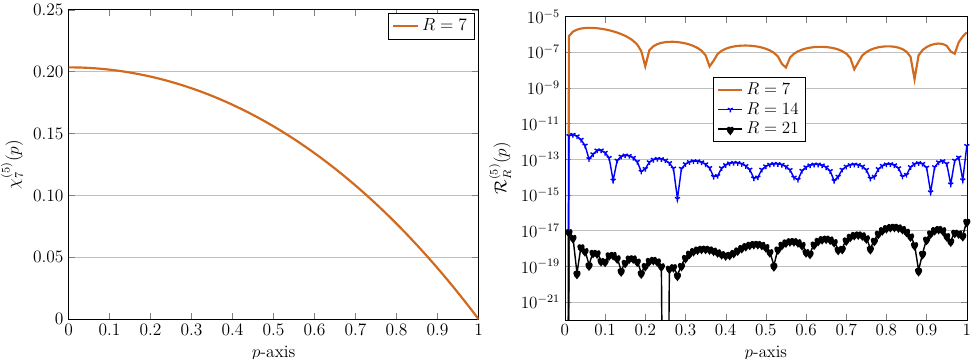
Figure 1. Graphics of numerical solution obtained via QLM-SAPSK approach ( left ) and related REFs 2 = 1, R = 7, and with integer-orders θ = 2, λ = 1. ( right ) using δ , H